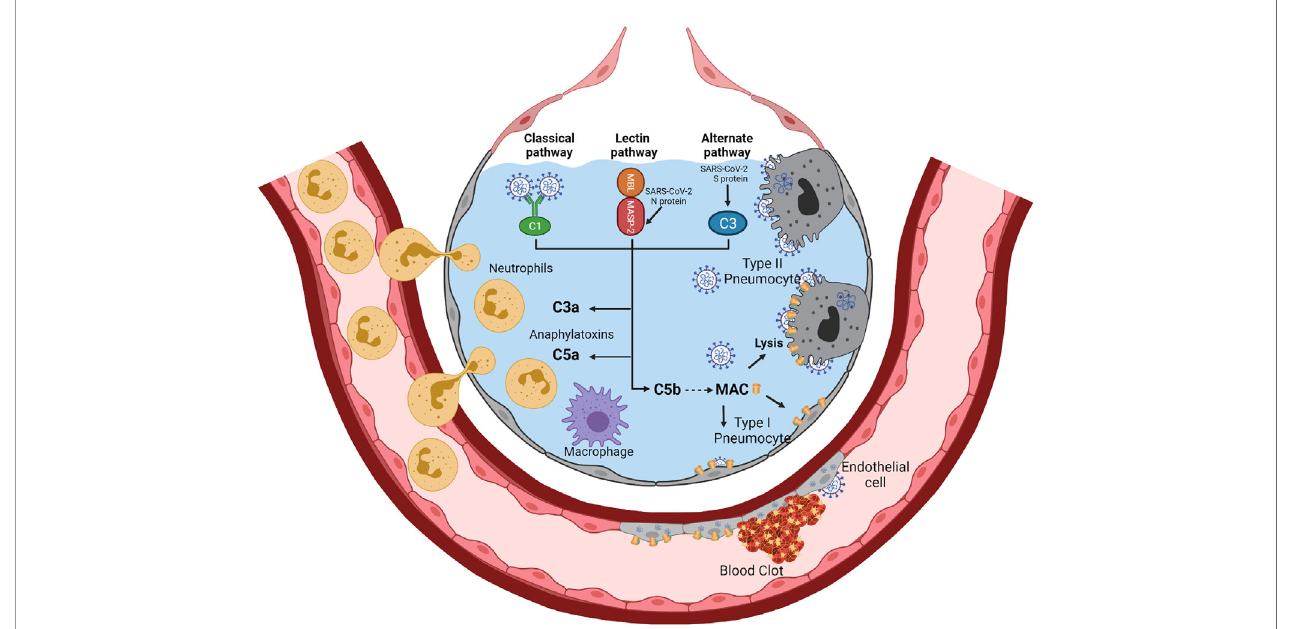
FIGURE 2 | Complement activation during SARS-CoV-2-related ARDS. SARS-CoV-2 infection of alveolar epithelial cells (type II and type I) and endothelial cells may trigger complement activation via the three pathways of complement activation. The binding of the SARS-CoV-2 nucleocapsid protein to MASP-2 may activate the lectin pathway of complement activation. Activation of the alternative pathway could be facilitated by the lack of complement inhibitors (CD46, CD55, and CD59) on infected alveolar cells and virions. IgM to SARS-CoV-2 may ef fi ciently activate the classical pathway. The three complement activation pathways converge to generate the C3a and C5a anaphylatoxins and the Membrane Attack Complex (C5b-C9) (MAC). C3a and C5a are potent chemoattractants and in fl ammatory mediators that recruit and activate neutrophils and monocytes/macrophages. Deposition of MAC on the membranes of alveolar epithelial cells and endothelial cells leads to cell lysis. Complement overactivation may promote hypercoagulability and thrombosis via several mechanisms, including activation and injury of endothelial cells, platelet aggregation and platelet prothrombinase activation, and inhibition of fi brinolysis. Also, MASP-2, in addition to trigger complement activation, may cleave prothrombin to form activated thrombin. Created with